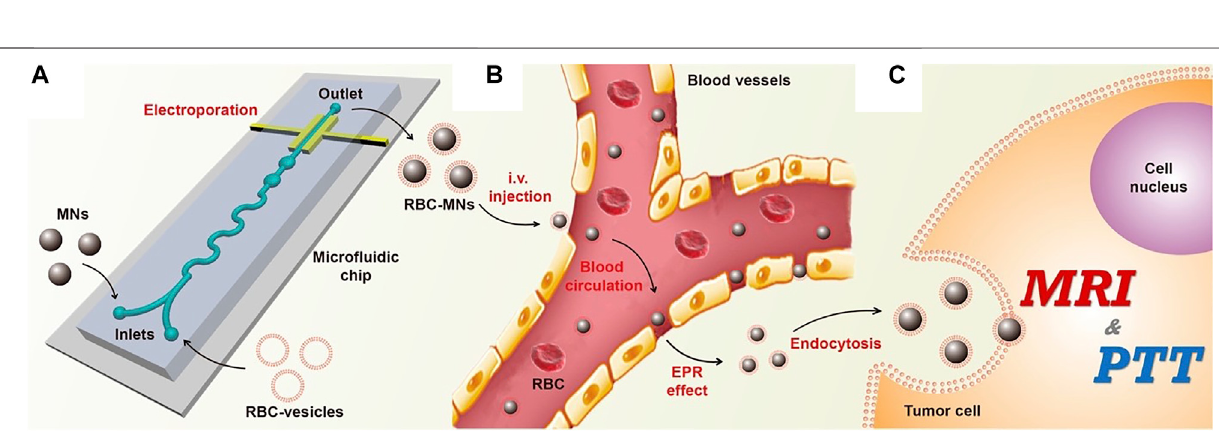
Frontiers in Chemistry |